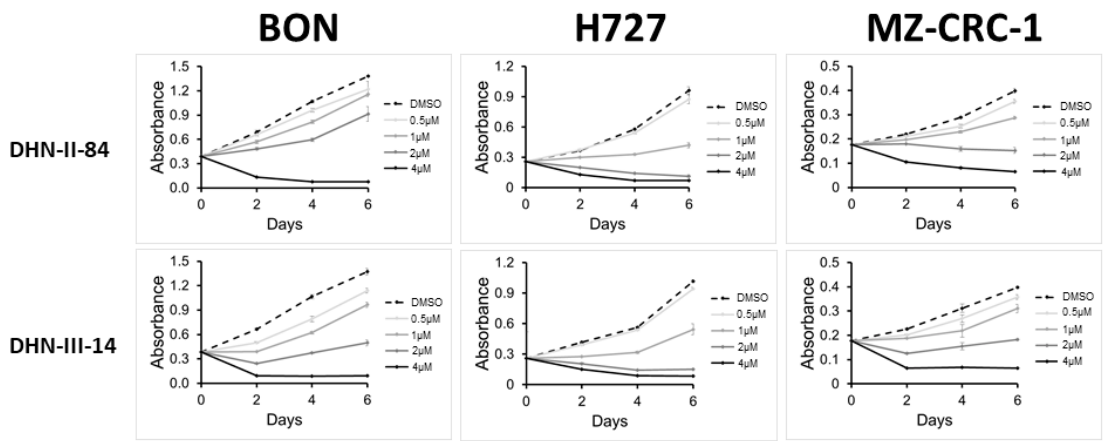
Figure 5. DNH-II-84 and DNH-III-14 inhibit neuroendocrine cell proliferation. BON, H727 and MZ-CRC-1 cell lines were treated with increasing concentrations of DNH-II-84 and DNH-III-14 (0–4 μ M). Absorbance was measured on day 0, 2, 4 and 6 using MTT assay. Experiments were performed